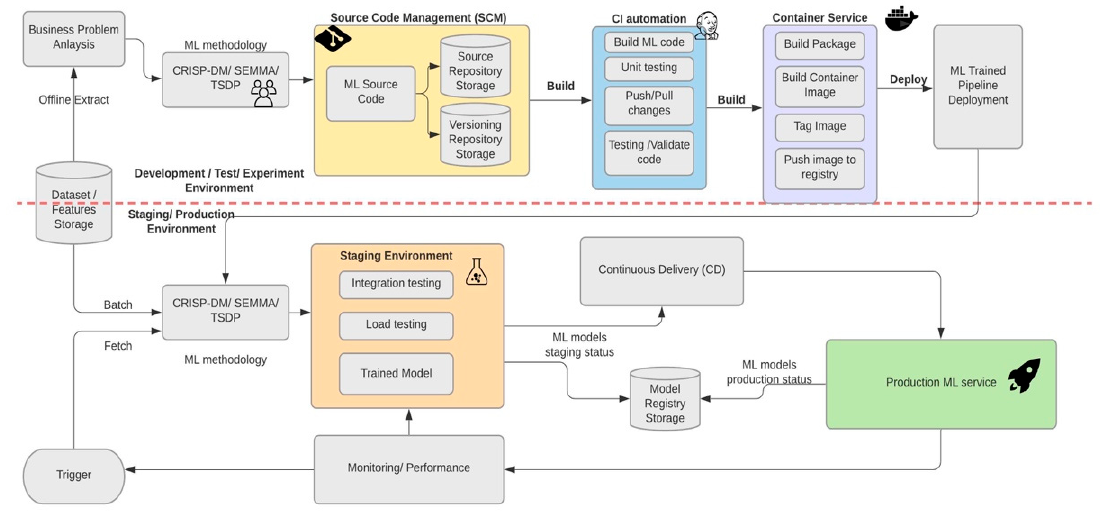
Figure 6. ML pipeline automation for CI/CD.